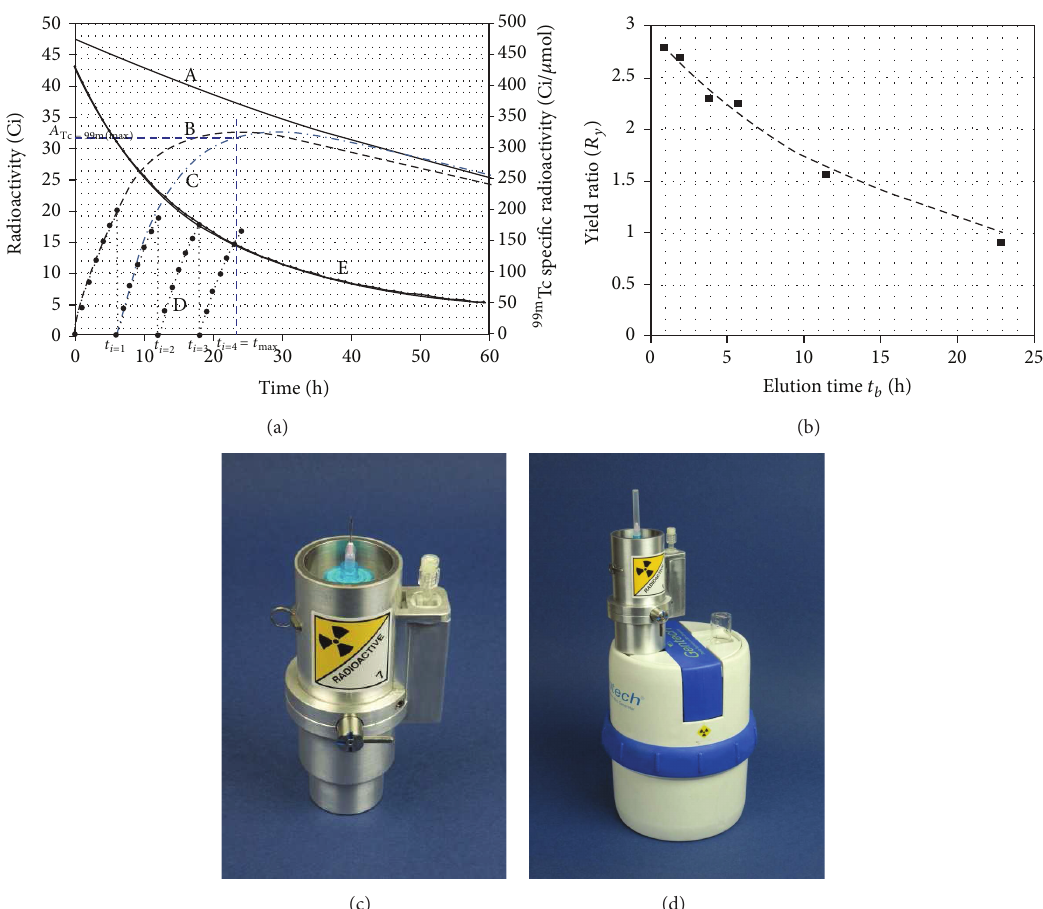
Figure 3: Radioisotope concentrator ULTRALUTE (patent-pending) and Effectiveness of 99 m Tc / 99 Mo utilisation: (a) kinetics of radioactive decay/ 99 m Tc-activity buildup in the generator eluted with an early elution regime (A: 99 Mo-activity; B: 99 m Tc-activity buildup from beginning; C: 99 m Tc-activity growth after first elution; D: 99 m Tc-activity growth/eluted at 6-hour elutions; E: 99 m Tc-SA in the system of 99 m Tc-radioactivity buildup from beginning) [58]; (b) effectiveness of “early” elution regime for increasing 99 m Tc-elution yield of the generator compared with that normally eluted at the time point of maximal 99 m Tc-buildup (square is experimental and dashed line is theoretical calculation result) [58]; (c) ULTRALUTE concentrator device [41, 61]; (d) ULTRALUTE concentrator device inline-coupled with a 99 m Tc